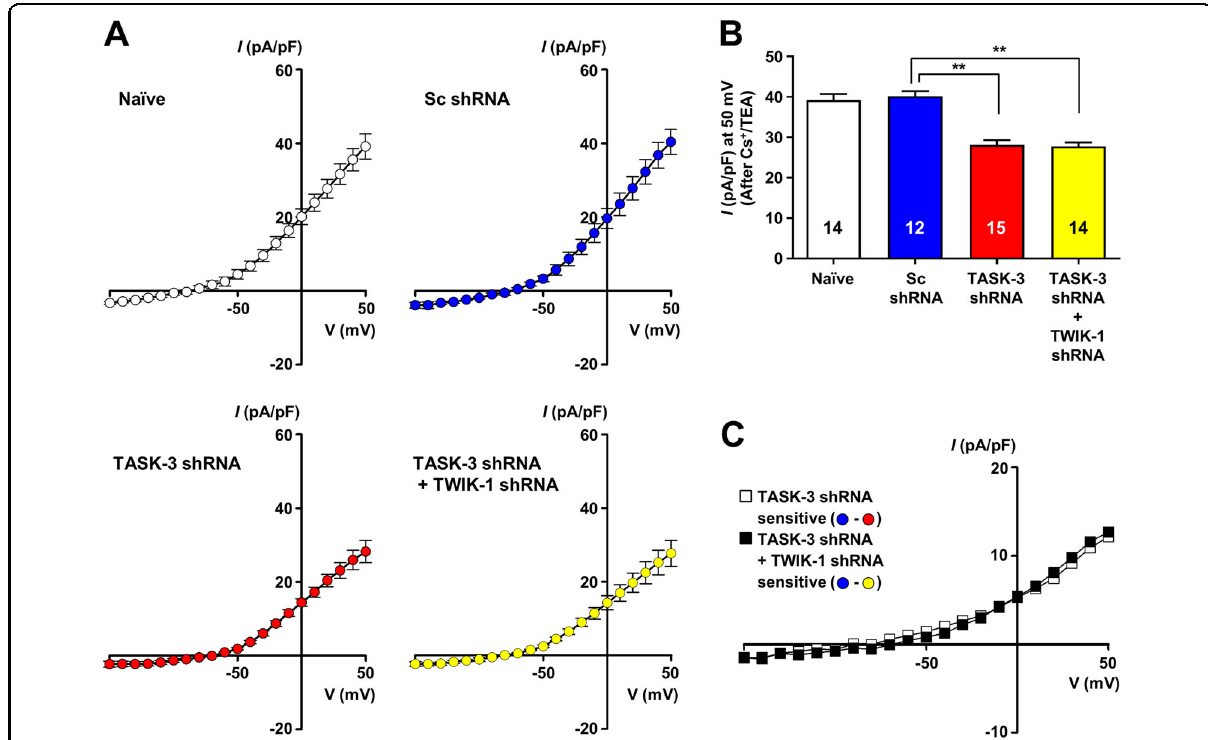
Fig. 3 TWIK-1/TASK-3 heterodimeric channels contribute to K + conductance in DGGCs. a The averaged current – voltage (I – V) relationship of the whole-cell currents from DGGCs infected with Ad-Sc or Ad-TASK-3 shRNAs or both Ad-TASK-3 shRNA and TWIK-1 shRNA as well as from naive DGGCs was measured in standard arti fi cial cerebrospinal fl uid in the presence of Cs + /TEA/4-AP (1 mM/5 mM/5 mM). Whole-cell currents were elicited by 1-s-duration ramp pulses descending from 50 mV to − 150 mV from a holding potential of − 70 mV. b A summary bar graph for a . The mean values of the current density in naive DGGCs ( n = 14 cells, N = 4 mice) or DGGCs expressing Sc shRNA ( n = 12 cells, N = 3 mice), TASK-3 shRNA ( n = 15 cells, N = 3 mice), or both TASK-3 and TWIK-1 shRNAs ( n = 15 cells, N = 3 mice) measured in the presence of Cs + /TEA/4-AP (1 mM/5 mM/5 mM) are shown. The current density values are depicted at + 50 mV. c The TASK-3 shRNA- or both TASK-3 shRNA- and TWIK-1 shRNA-sensitive currents were determined by subtracting each of the shRNA averaged currents from the Sc shRNA averaged currents a . ** P <